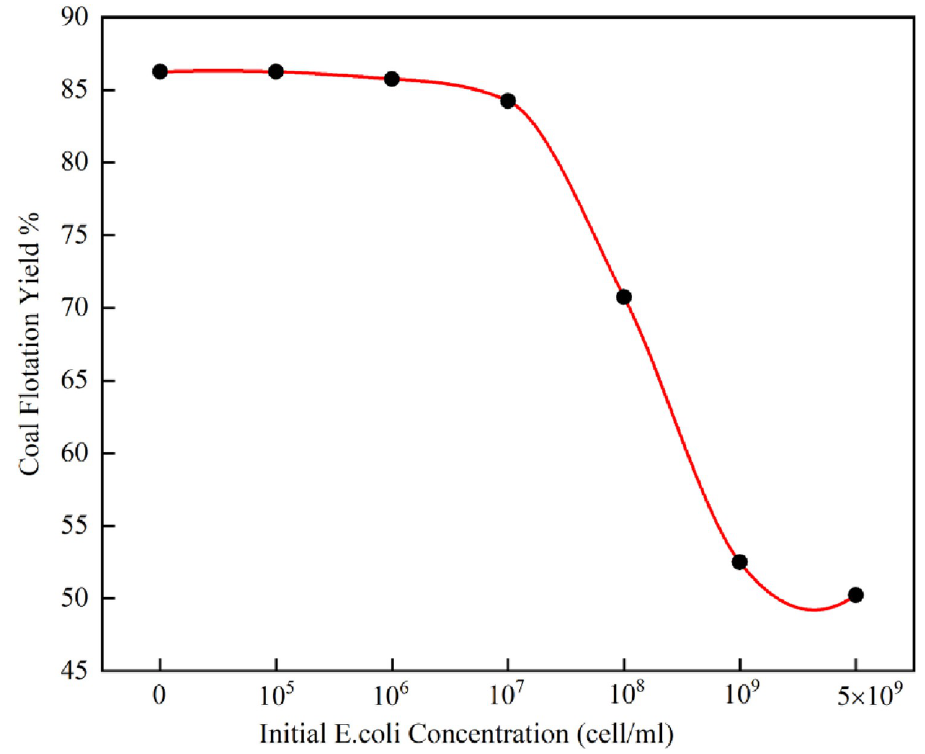
Fig 1. Effect of E . coli concentration on flotation recovery of